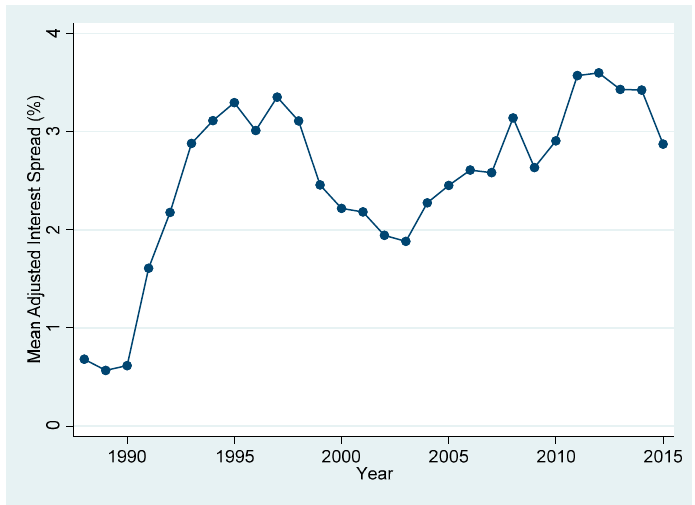
Figure 2. Mean adjusted interest spread of Chinese banks over the years until 2015.